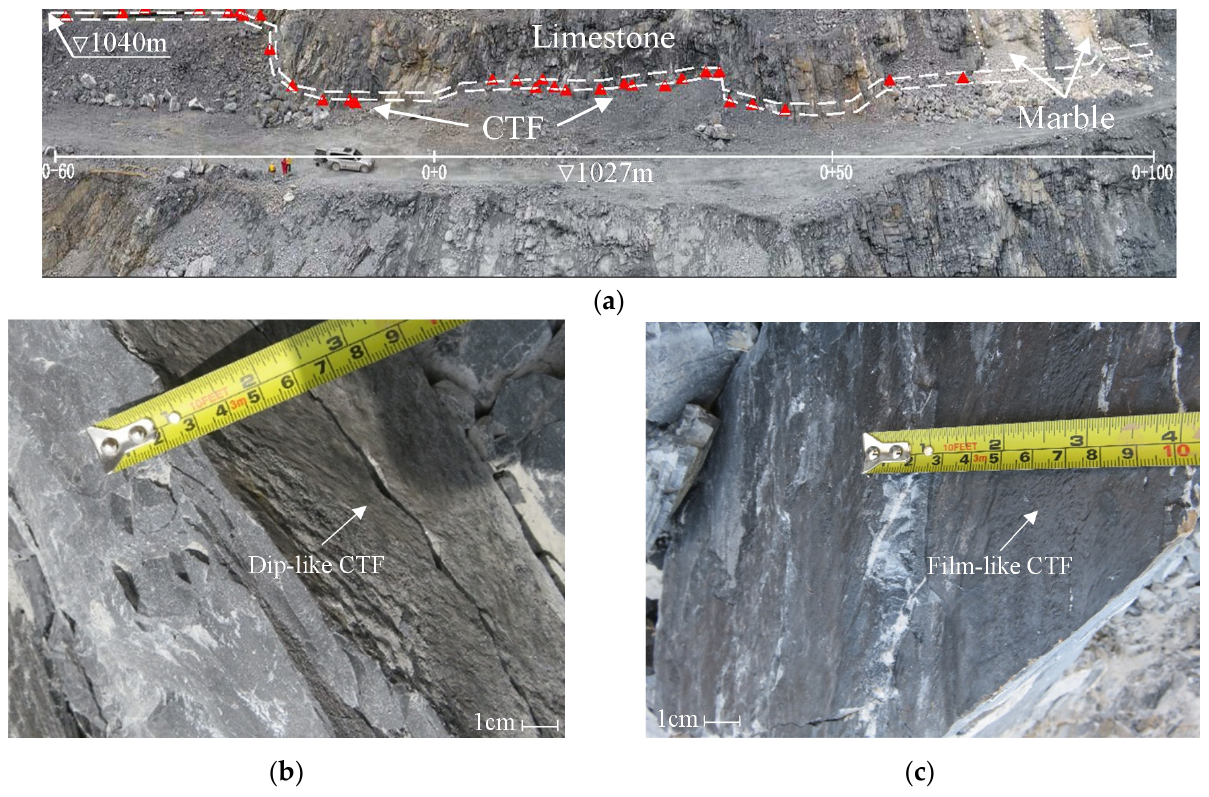
Figure 2. Distribution and present form of CTF in the limestone: ( a ) Distribution of the CTF; ( b ) Dip- like CTF; ( c ) Film-like CTF.